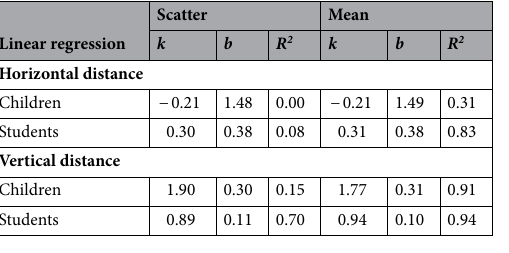
Table 4. Linear regression fitting results of the relation between horizontal/vertical position to the motion activation time of children and students.